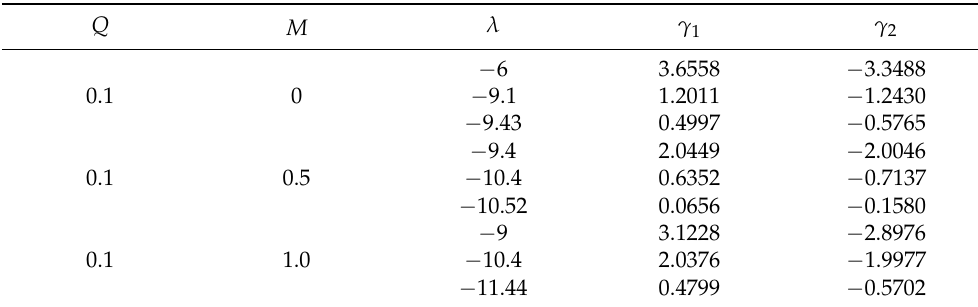
Table 6. The smallest eigenvalue γ with the variation of λ when Pr = 6.2, φ 1 = 0.01, φ 2 = 0.01, c = − 0.5, ξ = 1 and s = 1 for Fe 3 O 4 -CoFe 2 O 4